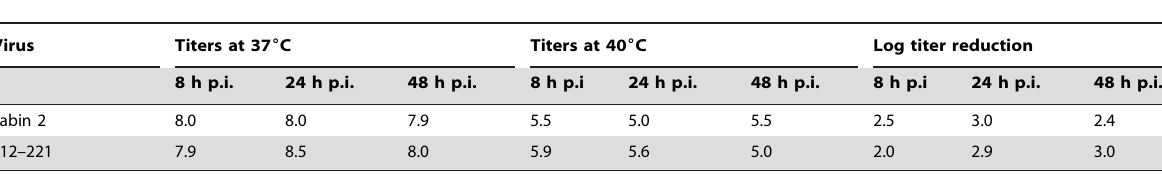
Table 2. Temperature sensitivity of VDPV2 strain E12–221 and Sabin 2